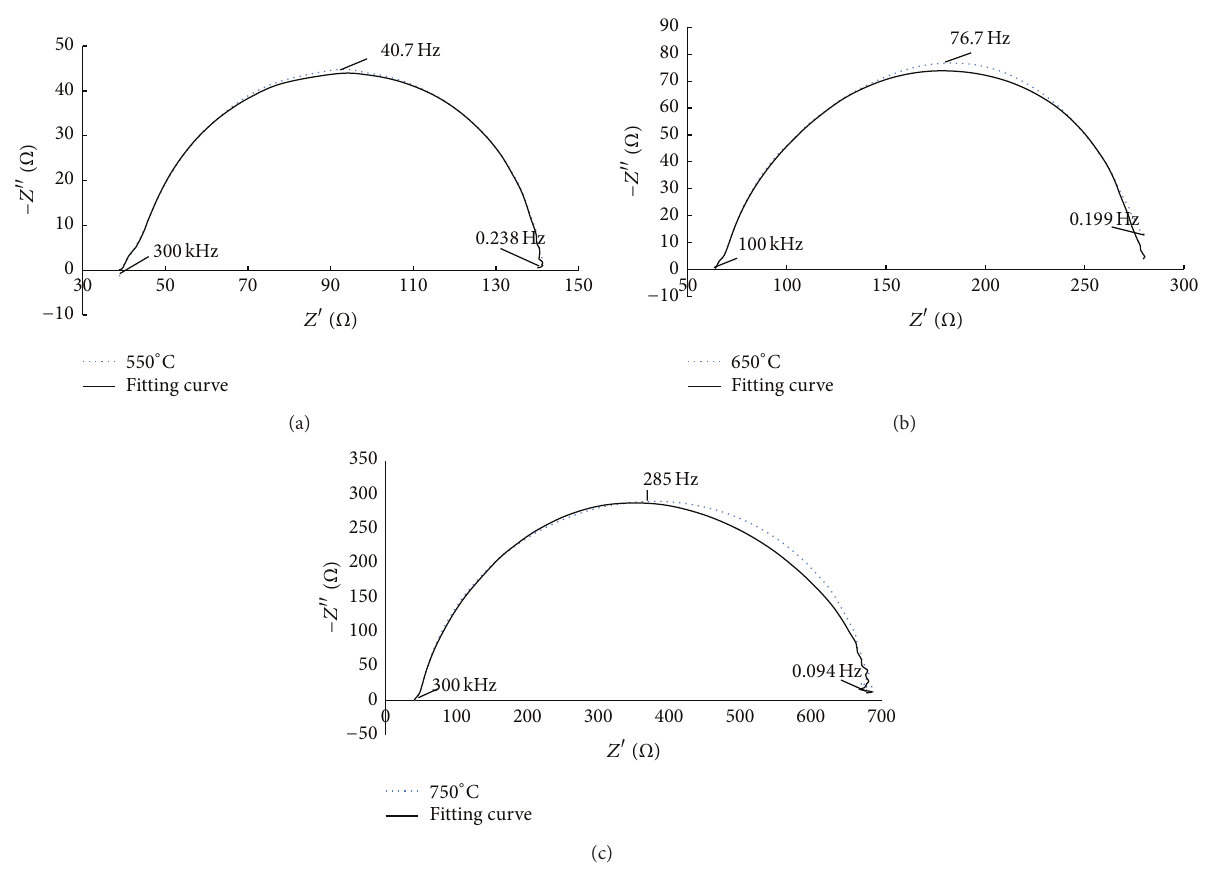
Figure 13: Electrochemical impedance spectroscopy (EIS) measurements for (a) 550 ∘ C, (b) 650 ∘ C, and (c) 750 ∘ C. Table 5: Parameters determined by electrochemical impedance spectroscopy